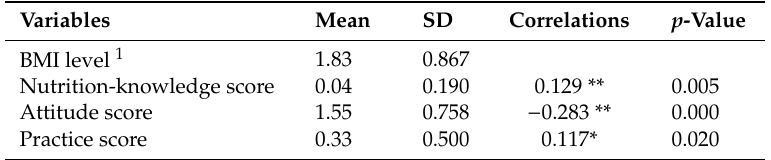
Table 8. Correlation analysis between the knowledge level of reproductive-age women in Sri Lanka and BMI